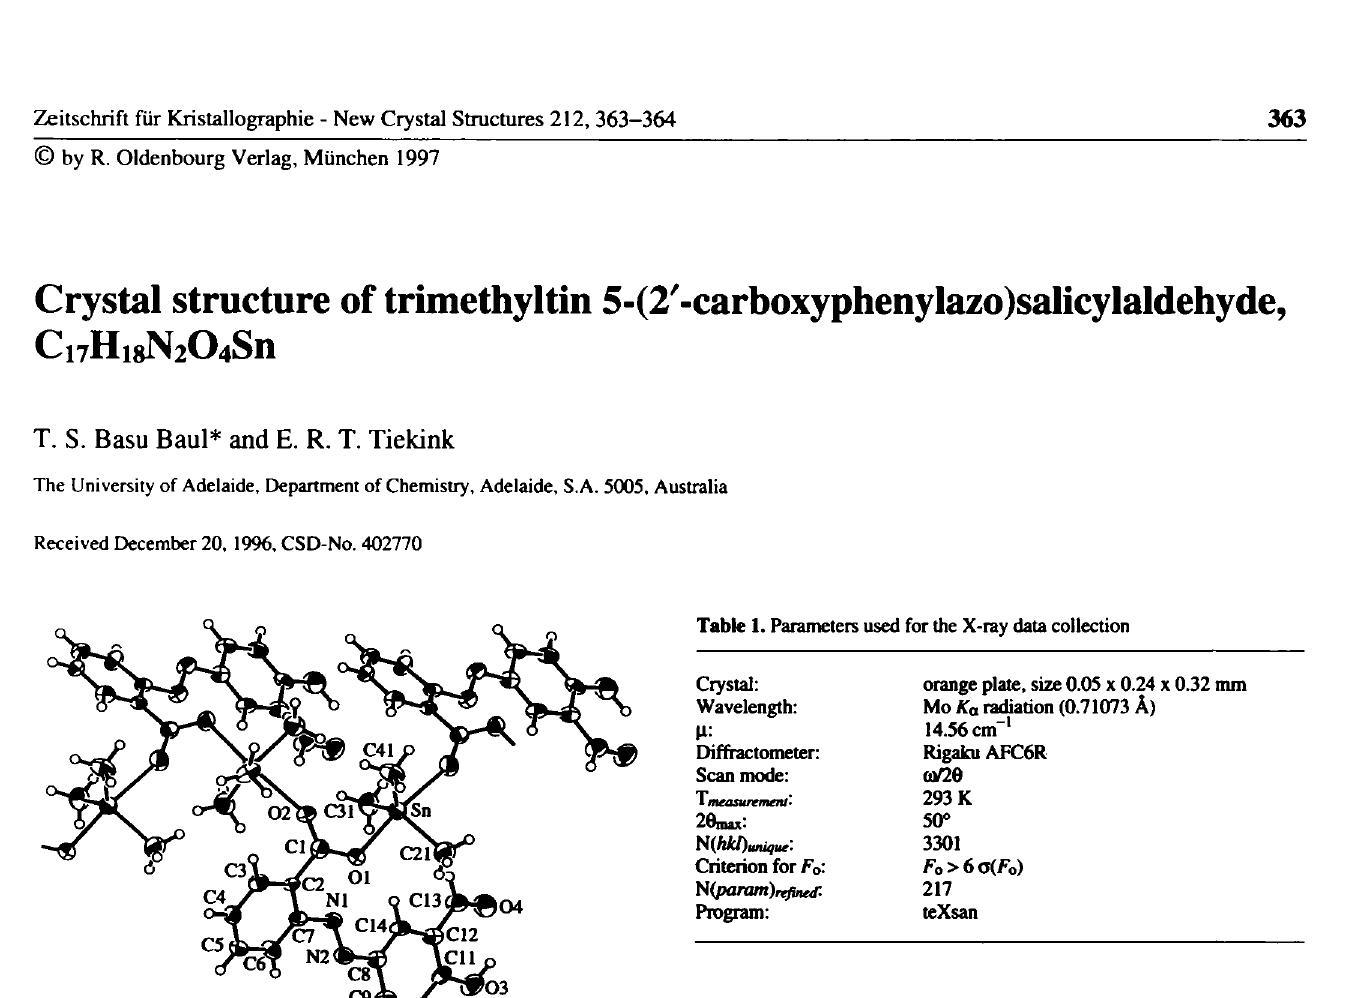
Table 2. Final atomic coordinates and displacement parameters (in Â 2